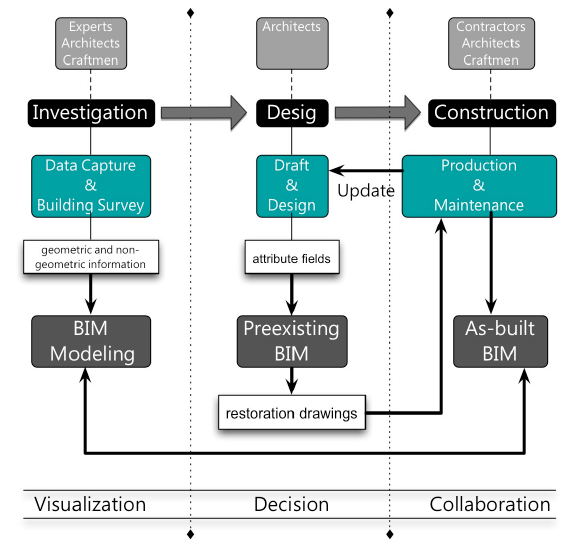
Figure 3. BIM creation workflow for Historic Building Repair